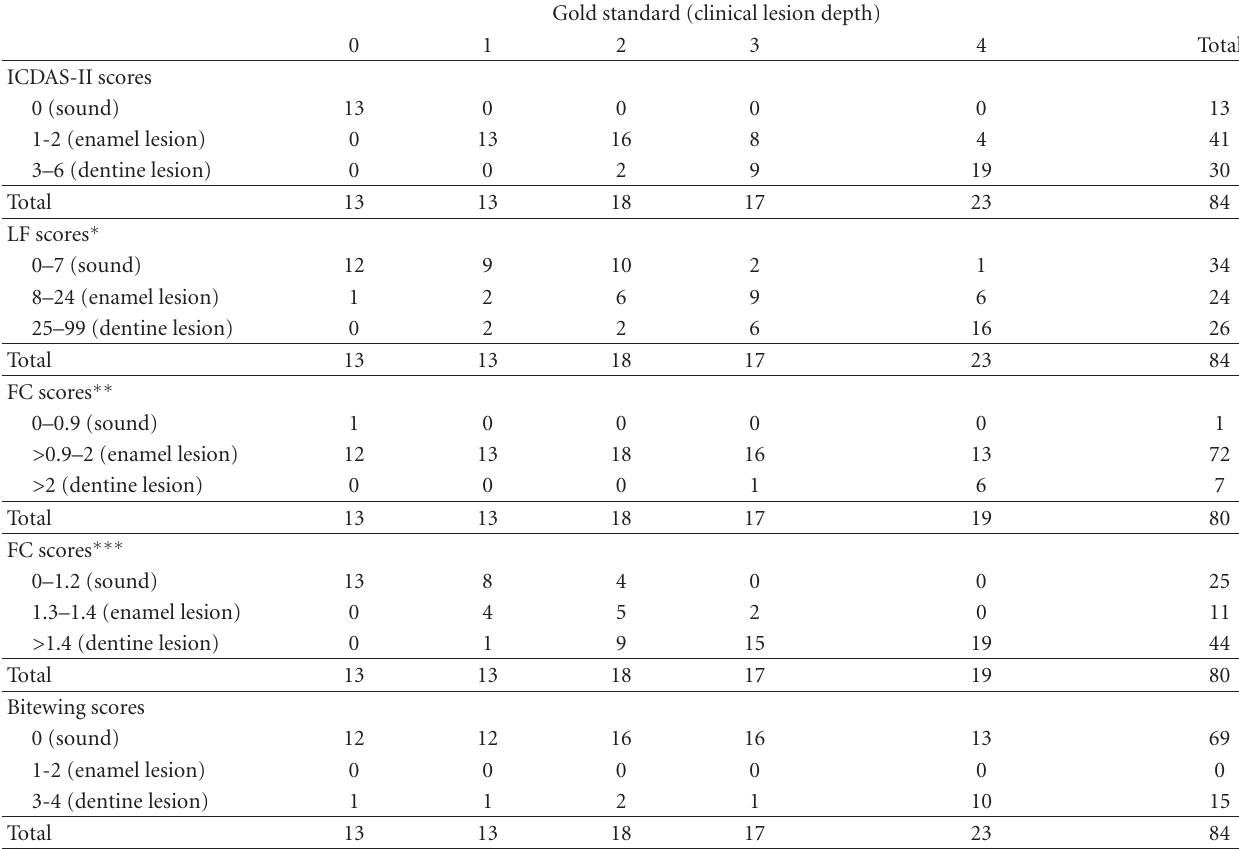
Table 1: Cross-tables showing the relationship between the di ff erent methods and the gold standard. Gold standard (clinical lesion